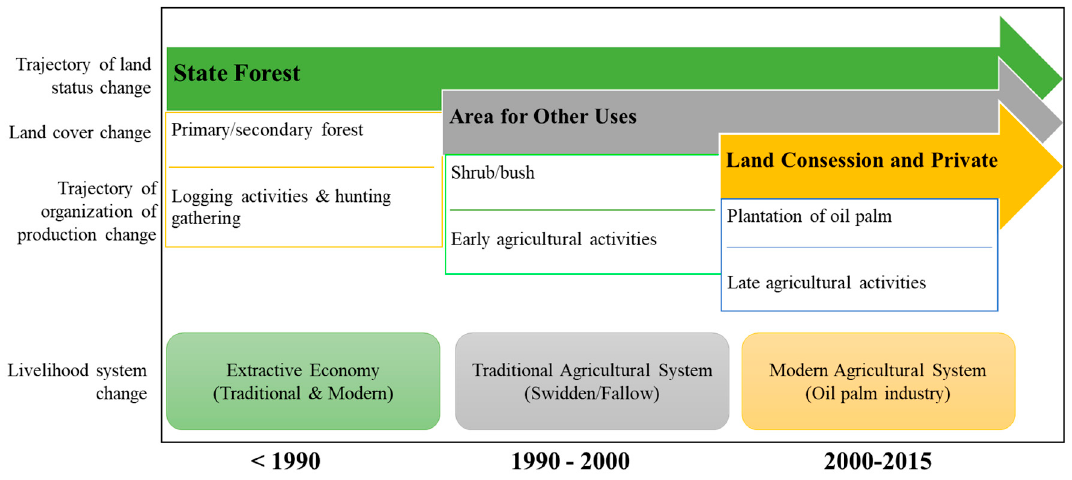
Figure 6. The evolution of land-use change from primary forest to oil palm plantation in the Kutai Kartanegara district, 1990–2015.